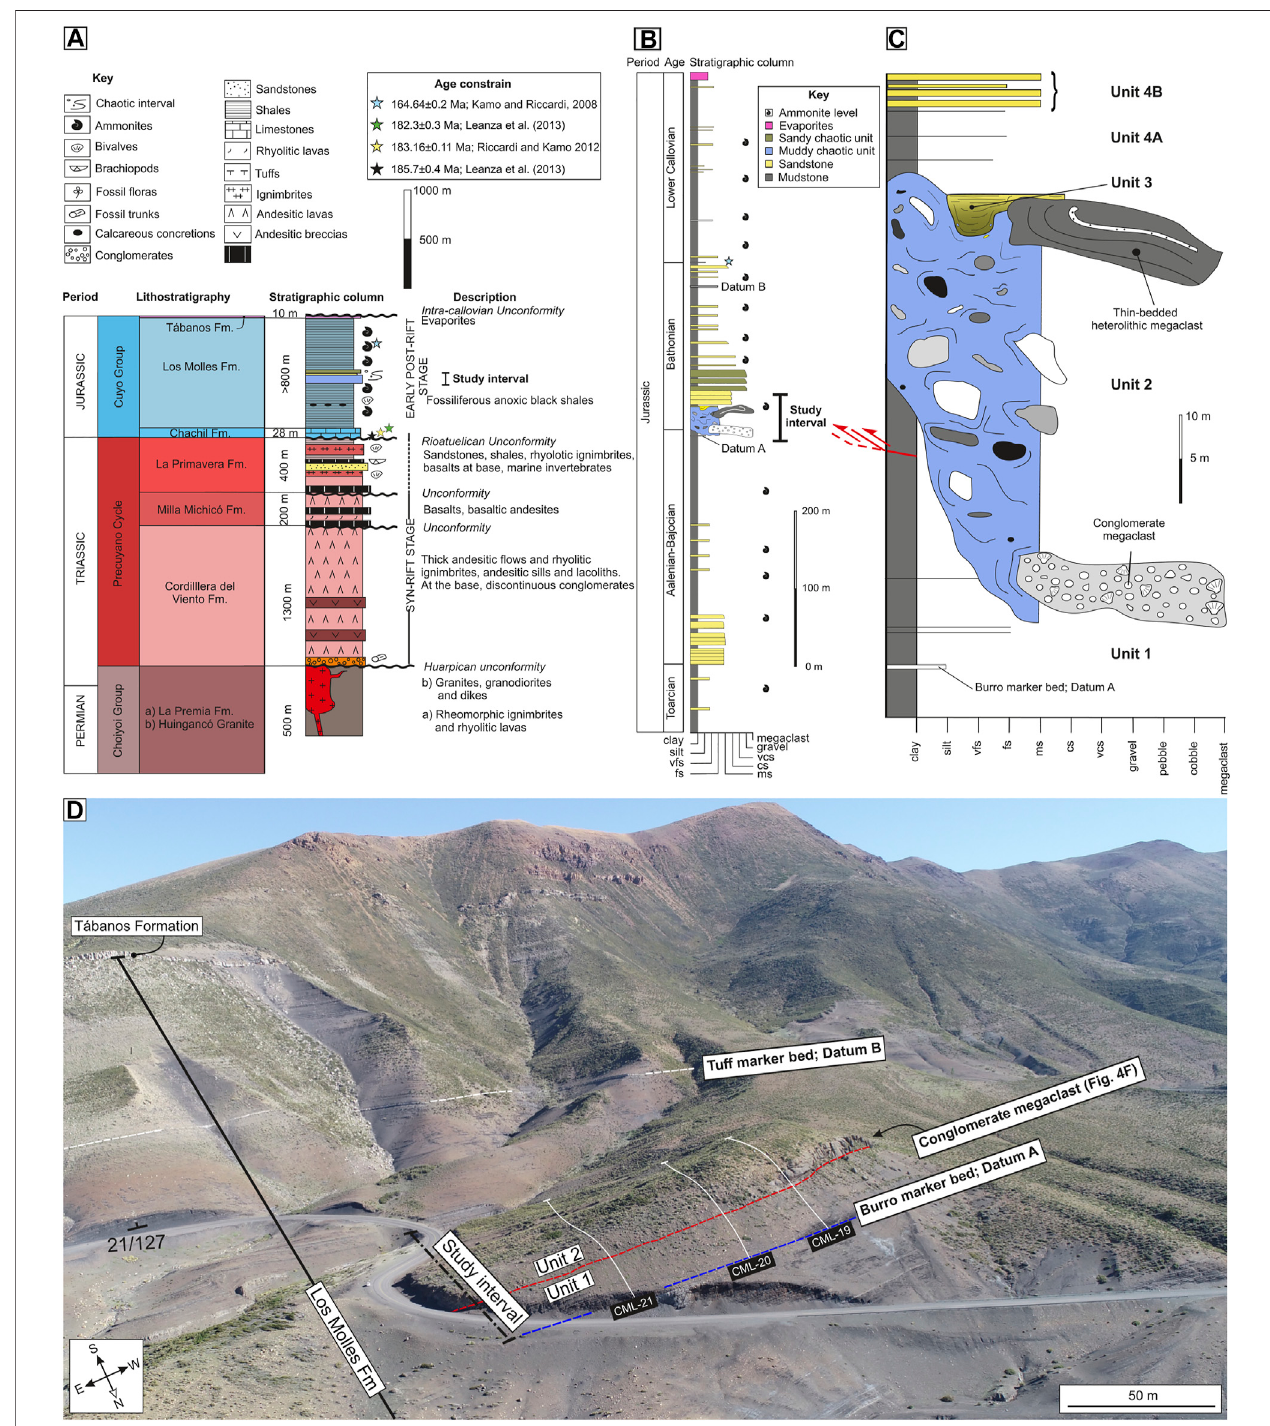
FIGURE 2 | (A) General stratigraphic column of Chacay Melehue showing the Los Molles Formation (modi fi ed after Gulisano and Gutiérrez Pleimling, 1995 and Llambíasetal.,(2007)andLeanzaetal.(2013)). (B) StratigraphiccolumnofLosMollesFormationandtheTábanosFormationintheChacayMelehuearea(modi fi edafter Gulisanoand Gutiérrez Pleimling, 1995. (C) Schematic logofthe studyinterval (D) Panoramic viewfrom UAV photograph (cars on the road forscale) showing thedeep- waterLosMollesFormation overlainbyevaporiticdeposits oftheTábanosFormation.Thestudyintervalandthetwodatumsused toconstrainthebaseandtopof the correlation panel are shown. See the location of logs 19, 20 and 21 ( Figure 3A ).